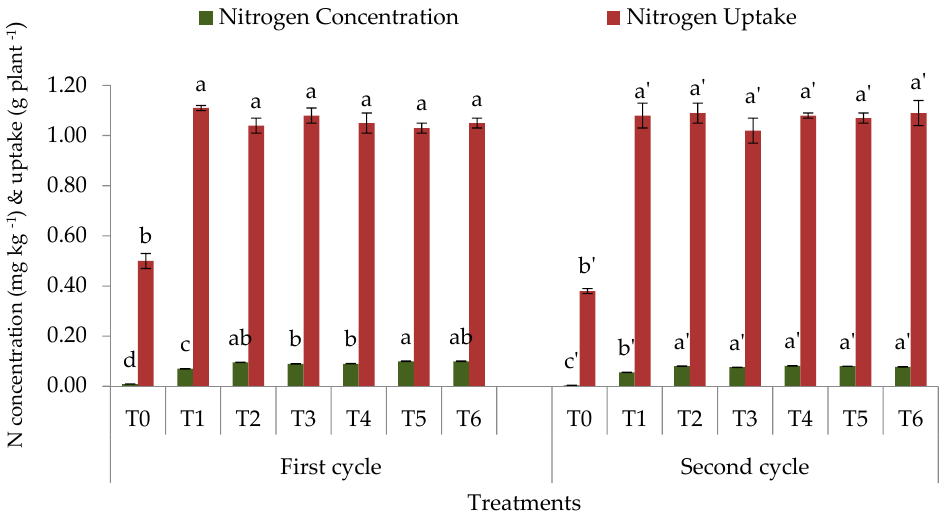
Figure 11. E ff ects of di ff erent fertilization practices on maize ear yield. Means with the same letter Figure 11. Effects of different fertilization practices on maize ear yield. Means with the same letter above the bars within a crop cycle are not significantly di ff erent at p ≤ 0.05. Bars represent the mean above the bars within a crop cycle are not significantly different at p ≤ 0.05. Bars represent the mean values ± standard error. values ± standard error .